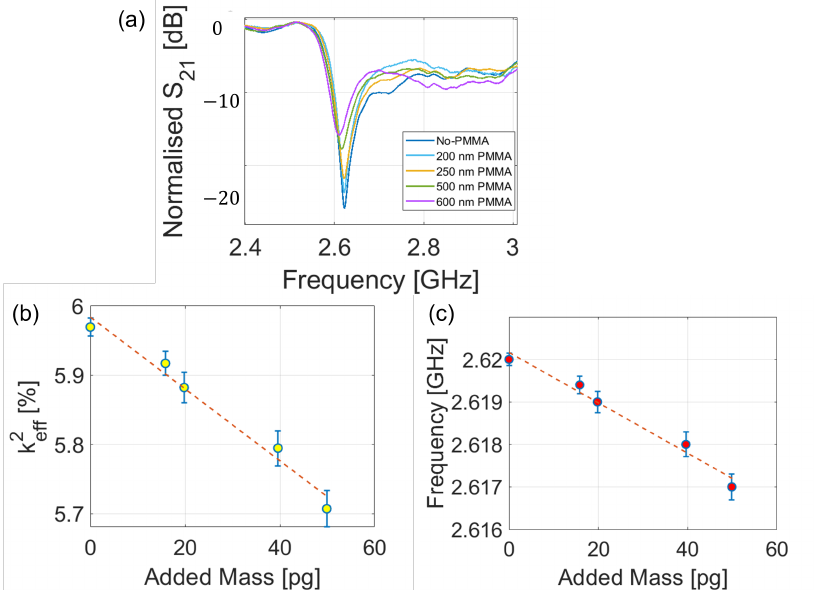
Figure 5. Experiment on the mass sensitivity of the FBAR. ( a ) Scattering parameter S 21 for differ- ent PMMA layer thicknesses, ( b ) k 2 versus added PMMA mass, and ( c ) frequency shift versus ef f PMMA